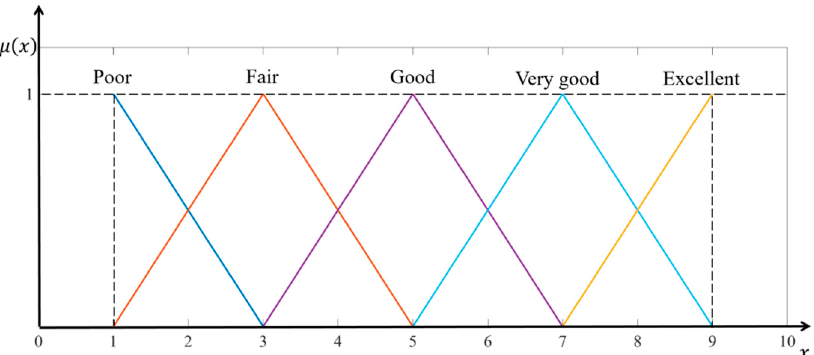
Figure 6. Evaluation of linguistic terms.